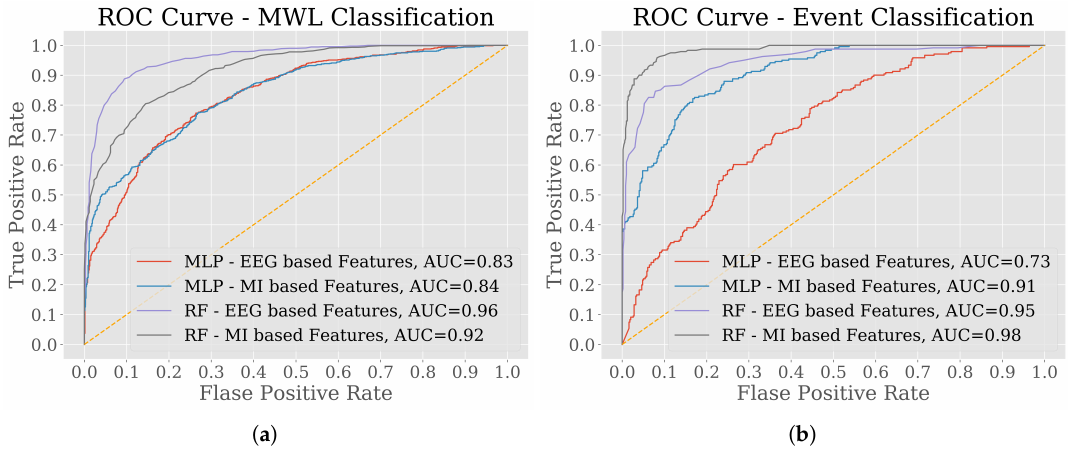
Figure 8. Receiver Operating Characteristic (ROC) curves for the best two classifier models among Logistic Regression (LgR), MLP, SVM and RF. The classifiers were deployed in two different binary classification tasks: ( a ) Low or High MWL and ( b ) type of events— Car or Pedestrian . For each of the tasks, all the classifier models were trained using 10-fold cross-validation